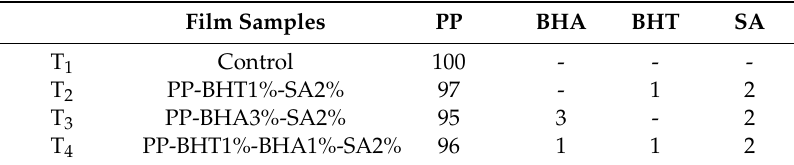
Table 4. Concentrations of antioxidants and antimicrobial agents part “Per Hundred Rubber” (PHR) in the formulation of PP-based